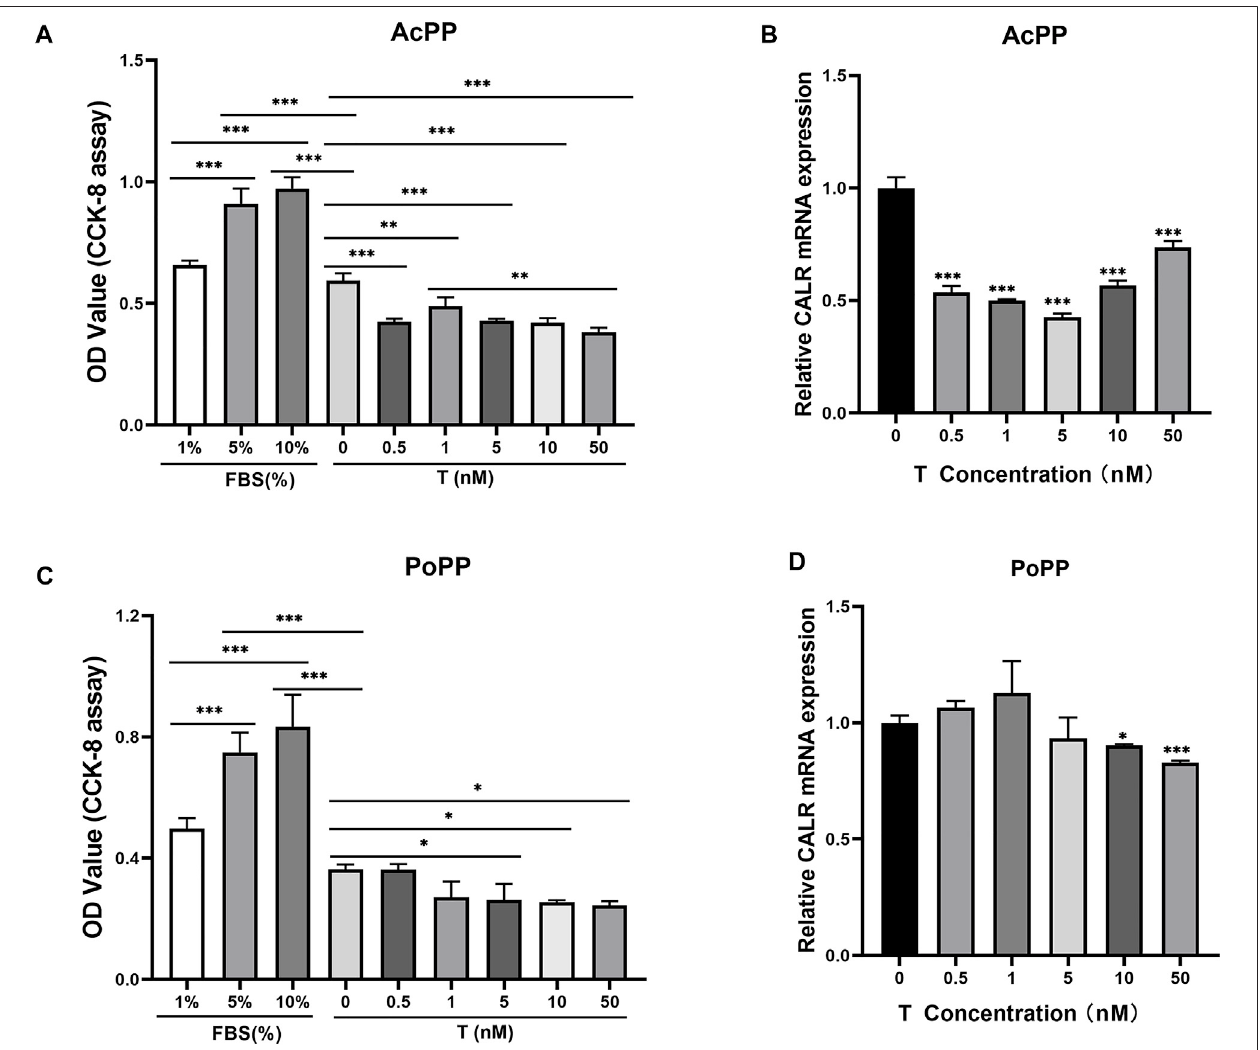
FIGURE 6 | Effects of testosterone (T) treatment on cell proliferation and CALR mRNA expression in the cells of the AcPP and the PoPP. (A,C) Effects of T (0.5 – 50 nM) on cell proliferation of the AcPP (A) and the PoPP (C) , respectively. Expression pro fi les of CALR mRNA in the AcPP (B) and PoPP (D) cells in serum-free medium with different concentrations (0.5 – 50 nM) of T; it is to be noted that T treatment decreased levels of CALR expression in these PP cells, with the effect being much greater in the AcPP than in the PoPP. * p < 0.05, ** p < 0.01, and *** p < 0.001.